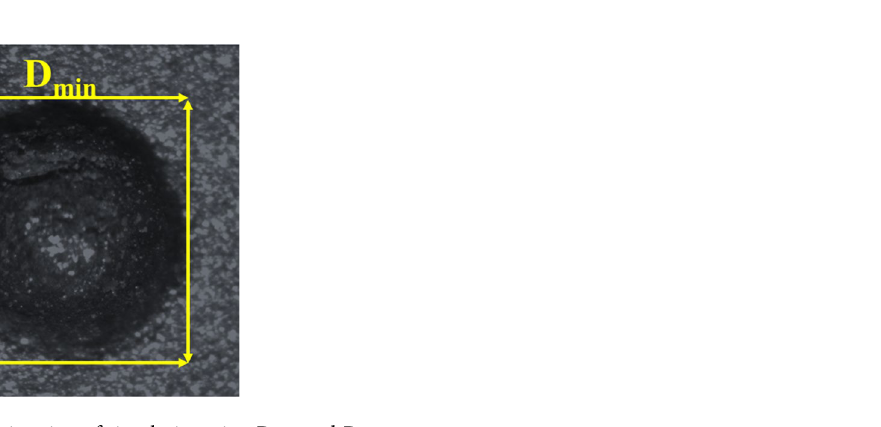
Figure 4. Estimation of circularity using D min and D max